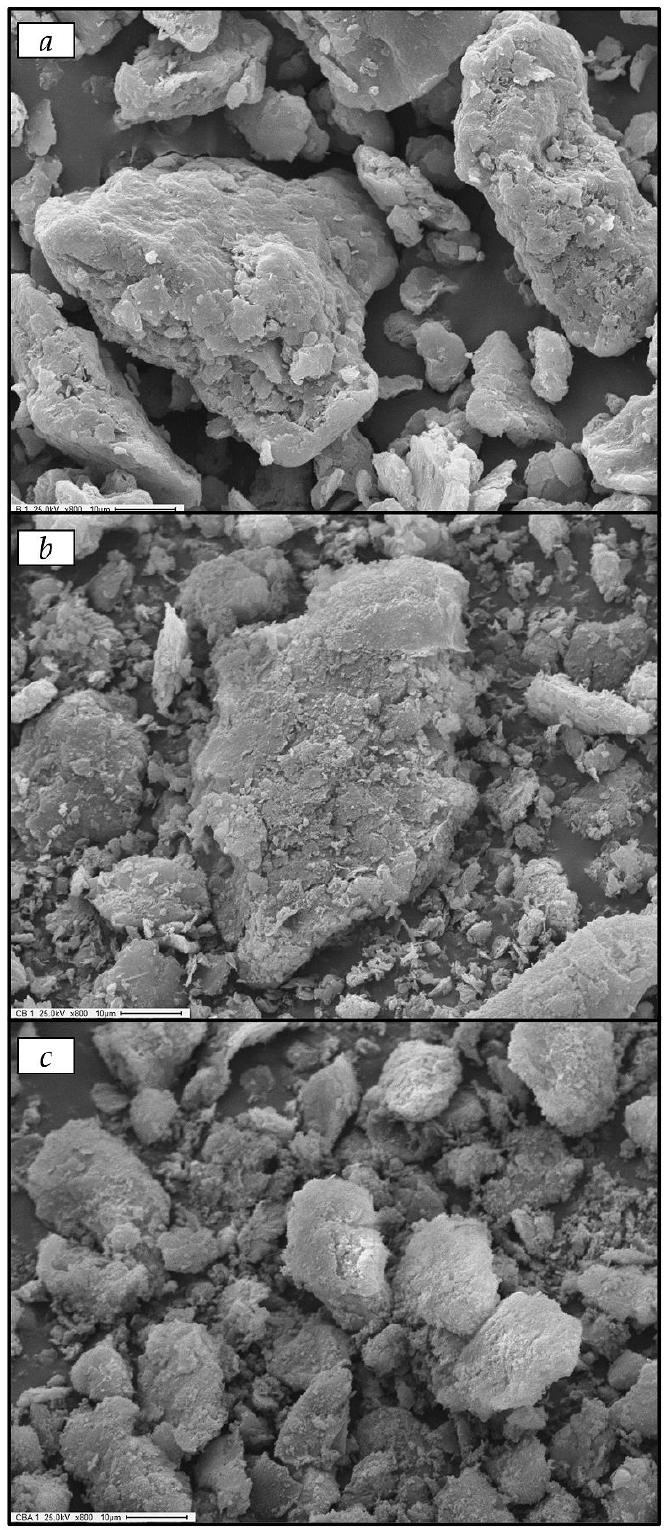
Figure 1. SEM images of: ( a ) natural bentonite B; ( b ) bentonite nanocomposite CB; ( c ) activated bentonite nanocomposite CBA.